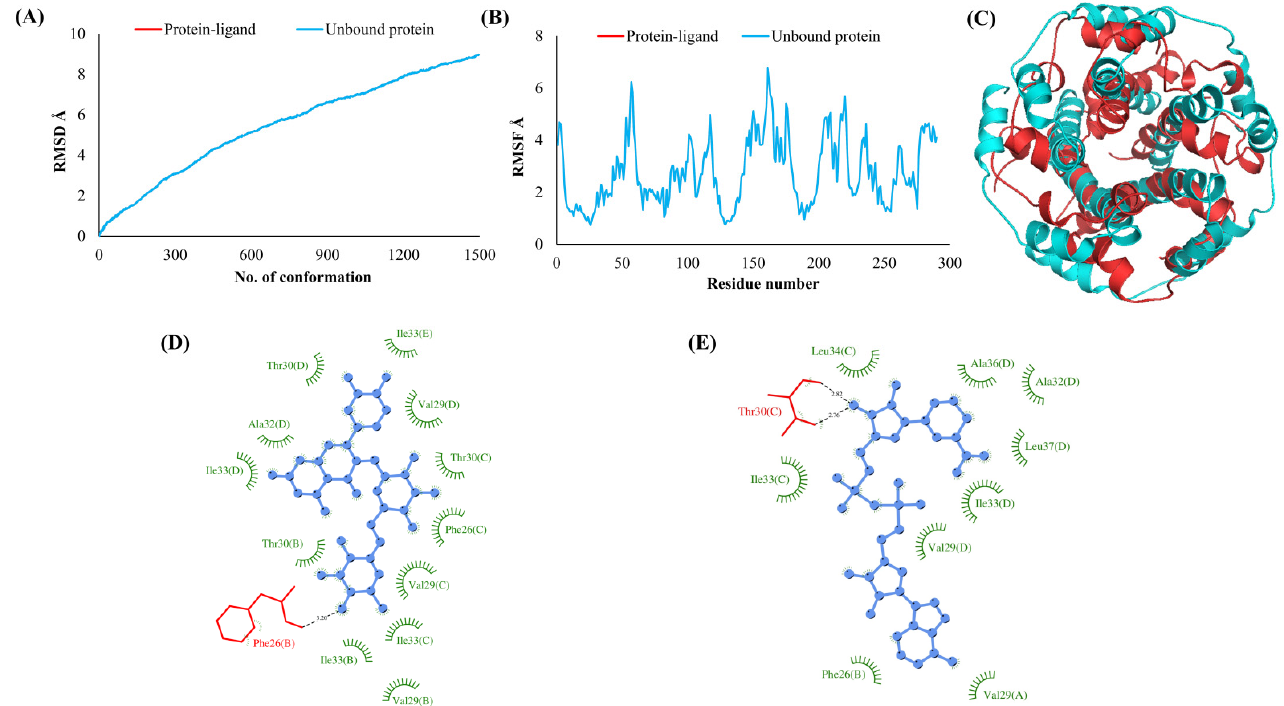
Figure 9. Spike (S). ( A ) RMSD plot of unbound and ligand-bound protein ( B ) RMSF plot of unbound and ligand-bound protein ( C ) Superimposition of unbound and ligand-bound protein ( D ) Molecular interactions of protein with Rutin ( E ) Molecular interactions of protein with NADH.